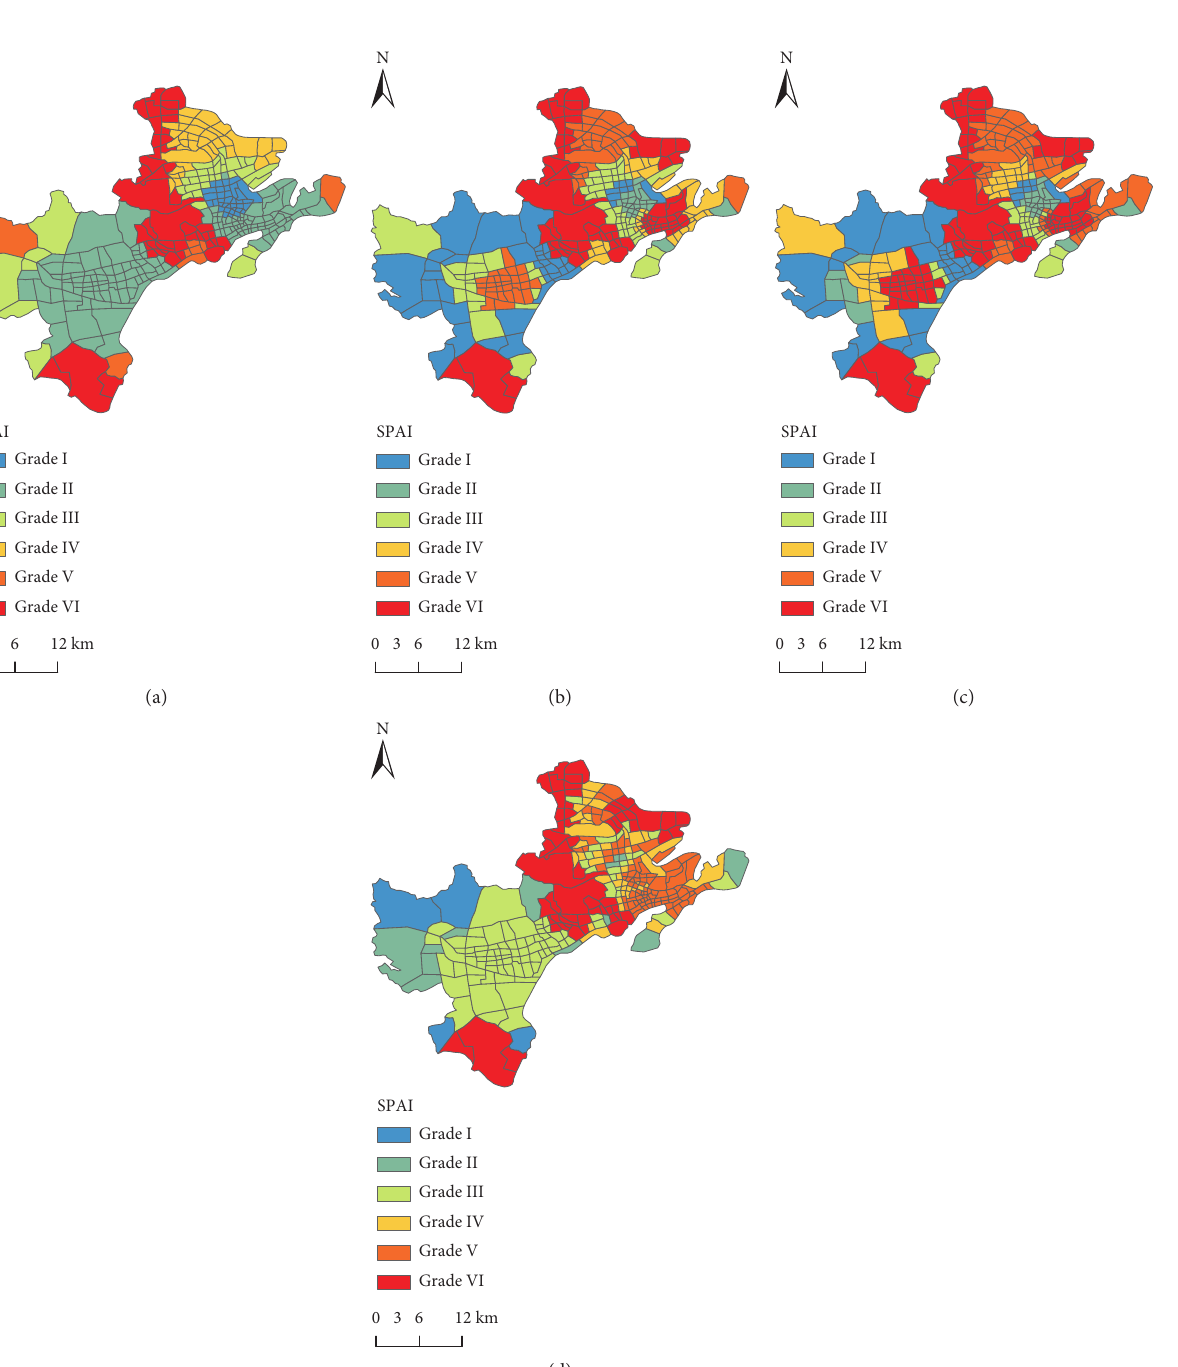
Figure 13: The different representations of degree for prehospital emergency care. (a) 2SFCA, (b) E2SFCA, (c) 3SFCA, and (d)